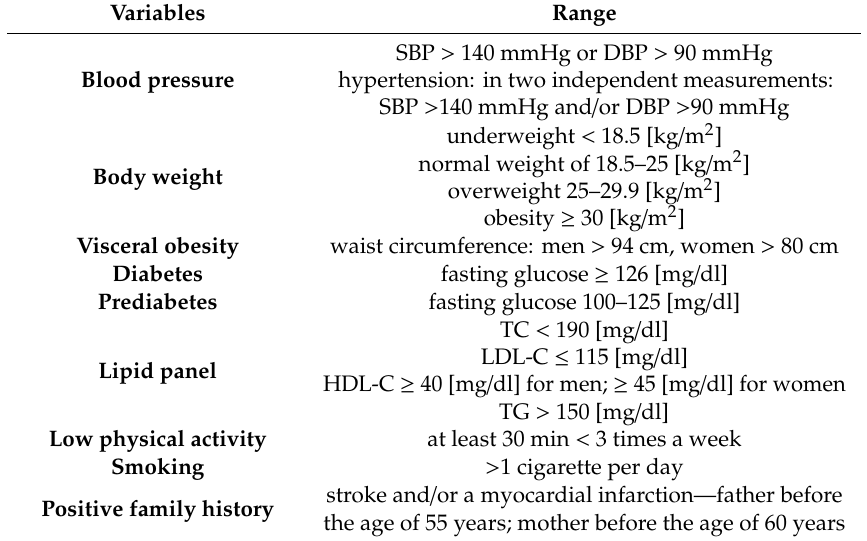
Table 1. Normal values for parameters and laboratory tests measuring the risk of cardiovascular